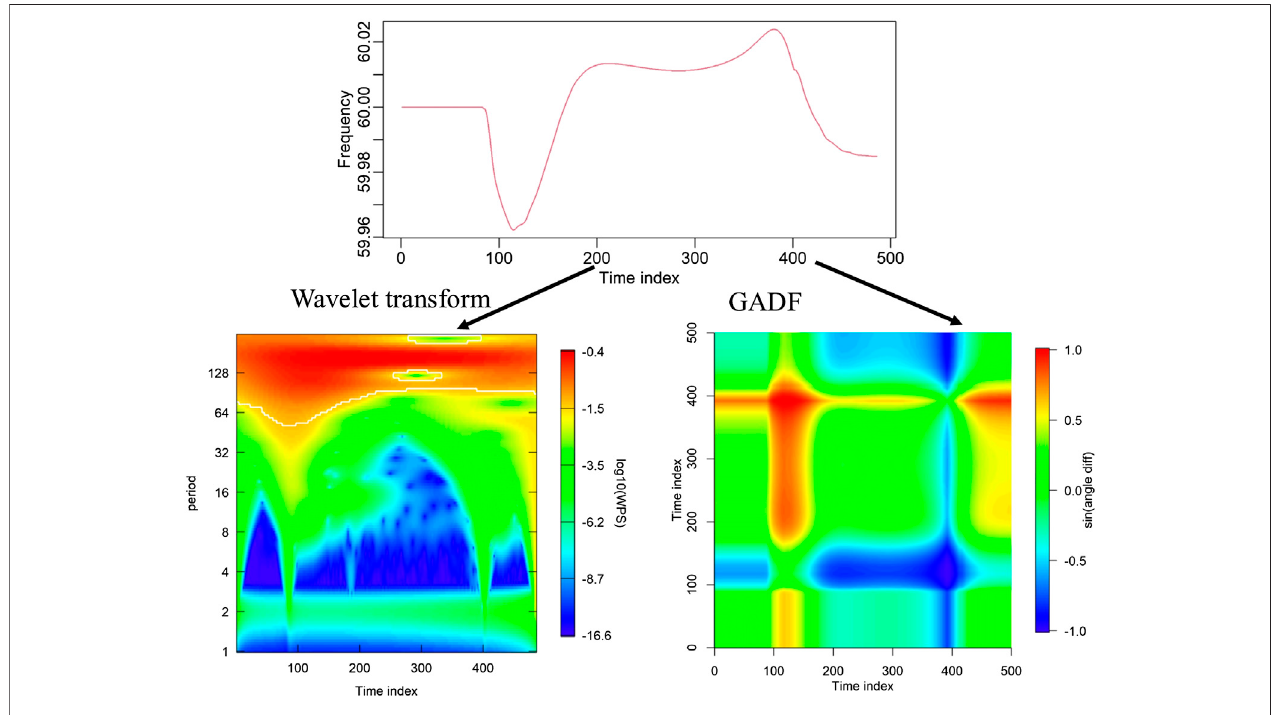
FIGURE 2 | A single time series imaged with two different encoding approaches.